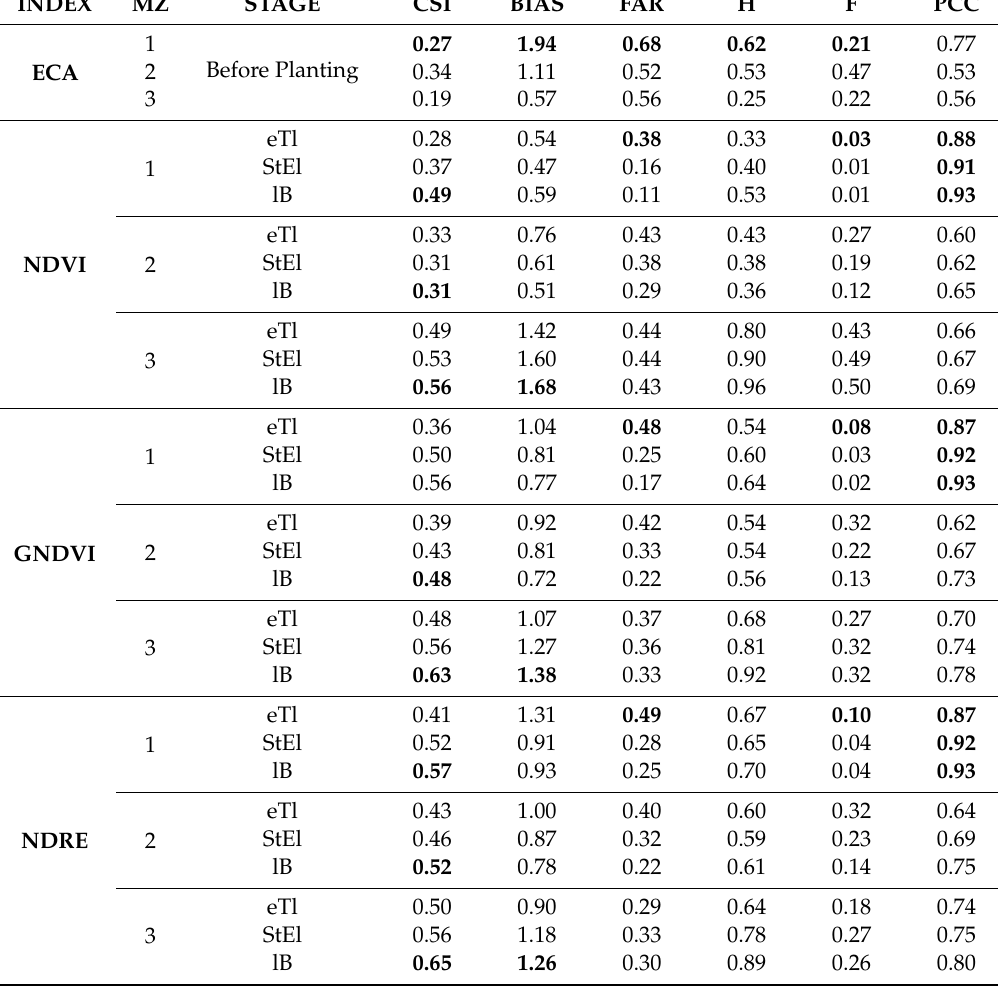
Table 2. Critical success index (CSI), BIAS, false alarm ratio (FAR), hit rate (H), probability of false detection (F), and the proportion of correct classification (PCC) were calculated separately for soil and vegetation indices, for MZs and development stage (before planting; early tillering, eTl; stem elongation, StEl; late booting,